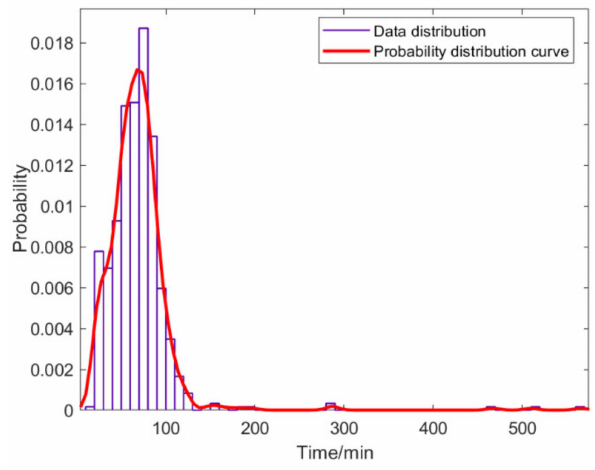
Figure 6. Data probability fitting results under nonparametric distribution.